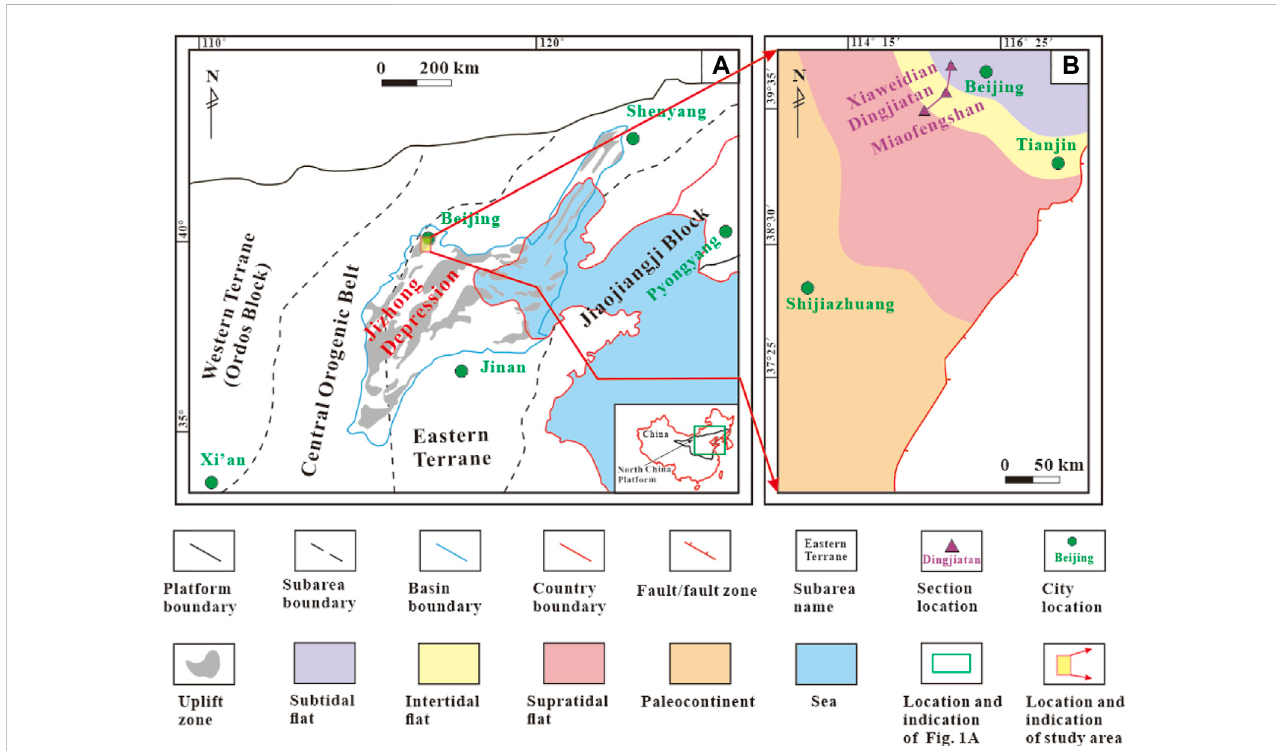
FIGURE 1 Map of the study area showing (A) an overview of the North China Platform and the location of the study area (adapted from Yu et al., 2022), and (B) the palaeogeography environment of the Cambrian Changping Formation and ths (adapted from Xiao, 2020).